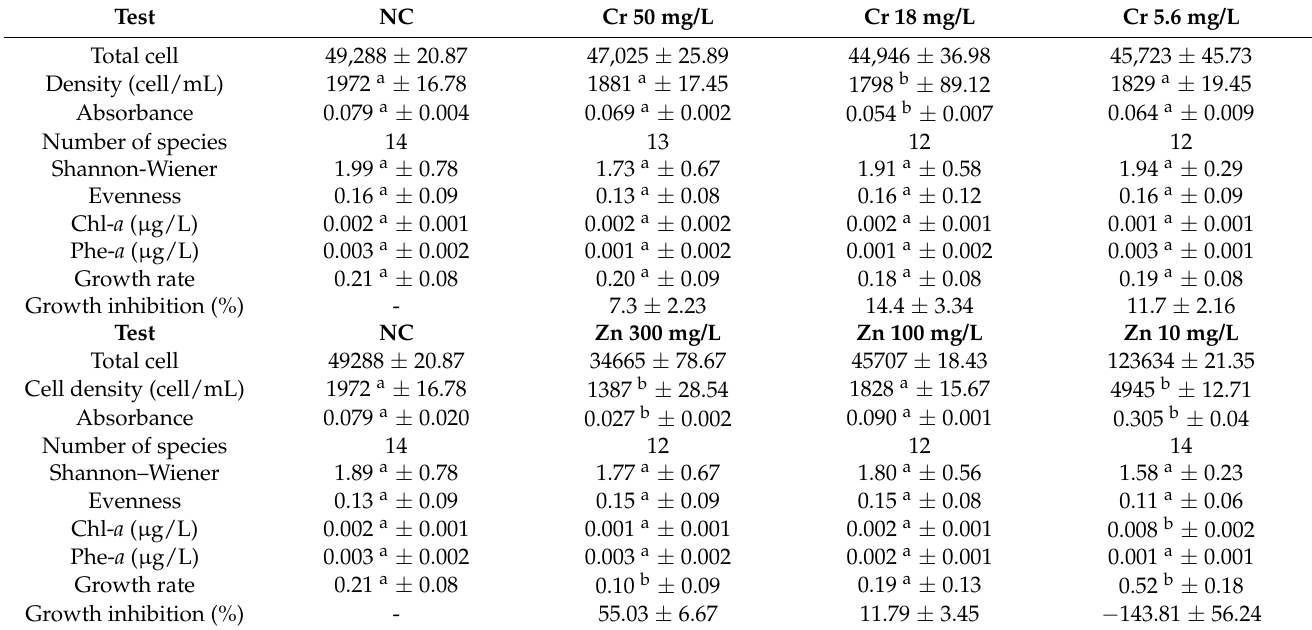
Table 1. Results of ecotoxicological assay of potassium dichromate-K 2 Cr 2 O 7 (Cr; a) and zinc oxide nanoparticles-ZnO NPs (Zn; b) on freshwater phytoplankton community. Lowercase letters ( a , b ) denote differences revealed by Conover–Iman post hoc or Mann–Whitney tests. NC denotes negative control. Phe- a = pheophytin- a ; Chl- a = chlorophyll- a